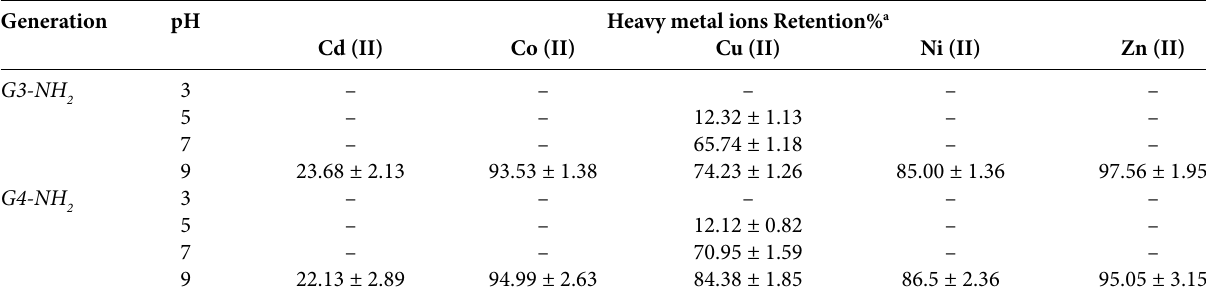
Table 4. Cd(II), Co(II), Cu(II), Ni(II), and Zn(II) retention% in aqueous solutions of JCPDs as a function of pH.